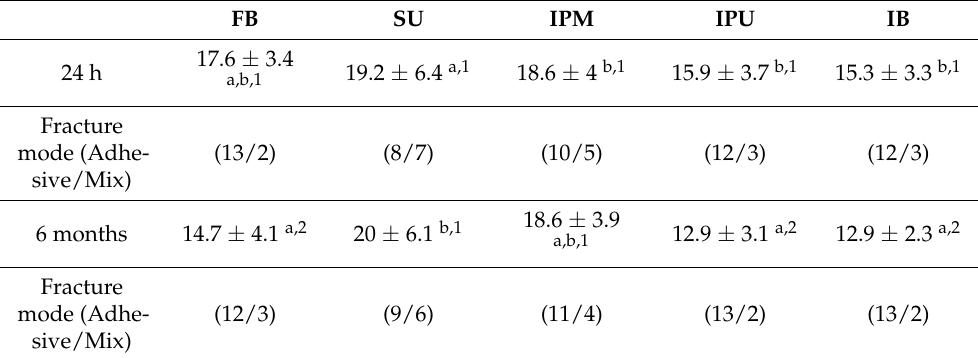
Table 2. Shear bond strength means and standard deviations of the five adhesives at the two storage periods and the number of adhesive or mixed failures. FuturaBond M+—“FB”, Scotchbond superscript letters indicate significant differences in rows, while different superscript numbers indicate significant differences in columns. Significance at 5% significant level ( p <